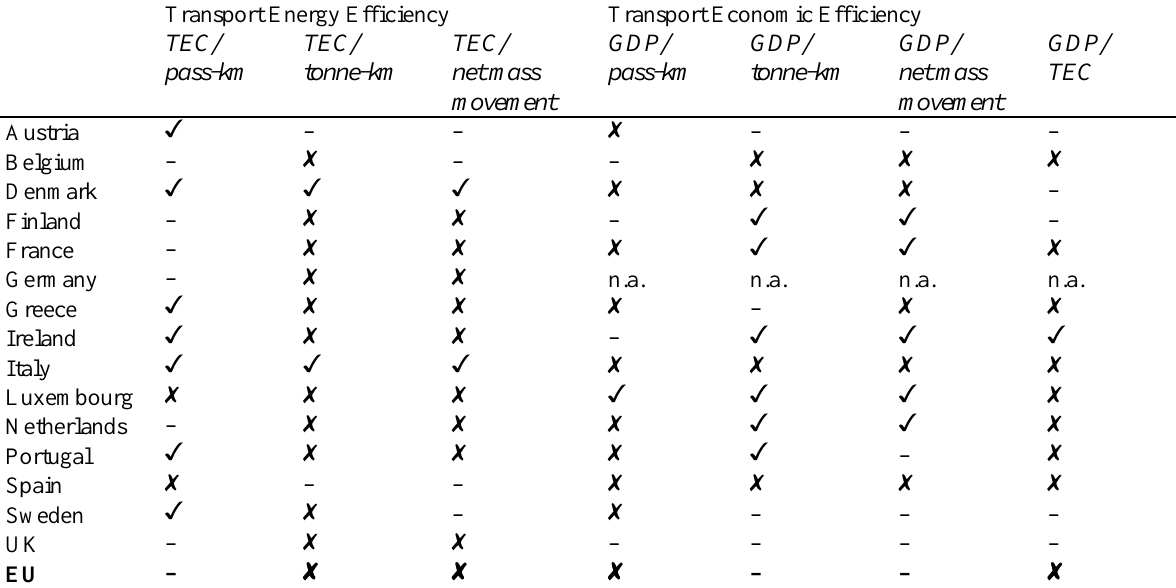
Table 3. Summary of Transport Intensity Trends in Europe,